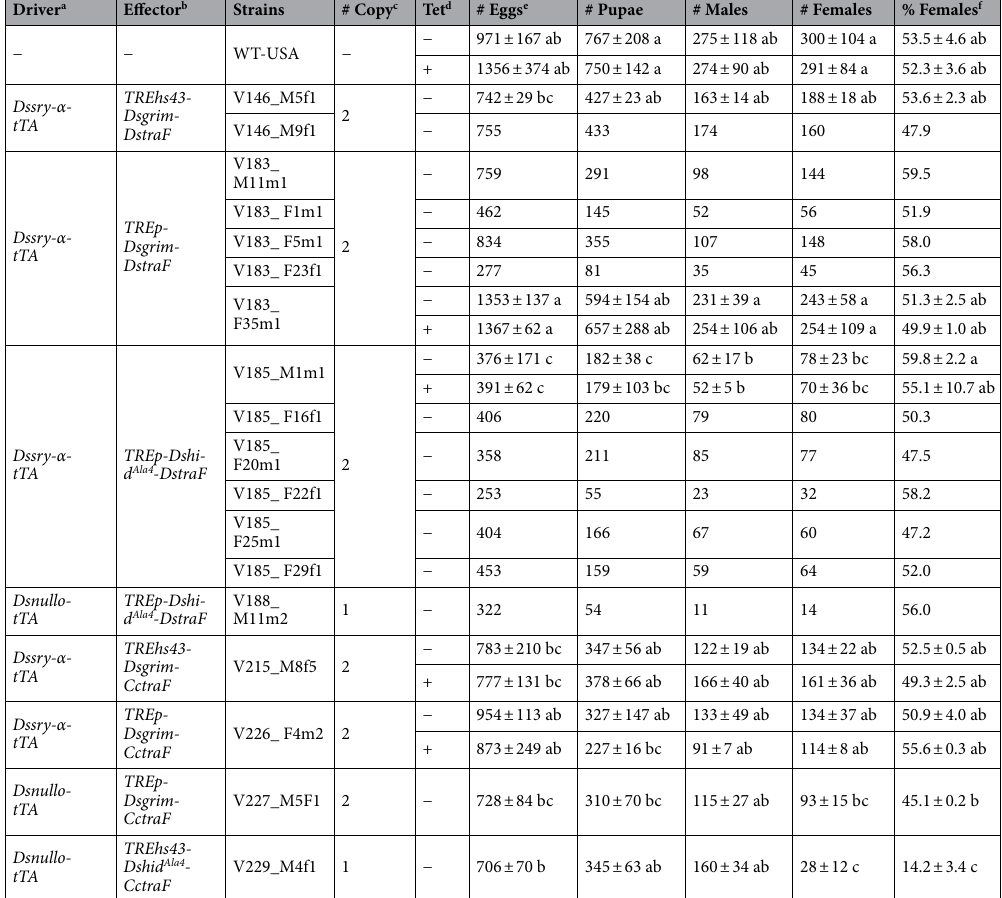
Table 1. Female lethality tests for different transgenic D. suzukii lines. a The driver cassette contains the Dssry-α or Dsnullo promoter for the regulation of tetracycline transactivator ( tTA ). b The effector cassette contains the minimal promoter p or hs43 fused to TRE, the pro-apoptotic gene Dsgrim or Dshid Ala4 , and the female-specific splicing intron DstraF or CctraF. c The tested strains carry either one copy (heterozygous) or two copies (homozygous) of the transgene. d The tests were carried out with (+) or without (−) tetracycline (Tet). e Data are shown as mean ± standard deviation for three biological replicates. Data without standard deviations represent one biological replicate. f The data in the same column followed by different lower-case letter are significantly different ( P < 0.05, one-way ANOVA, Holm-Šidák